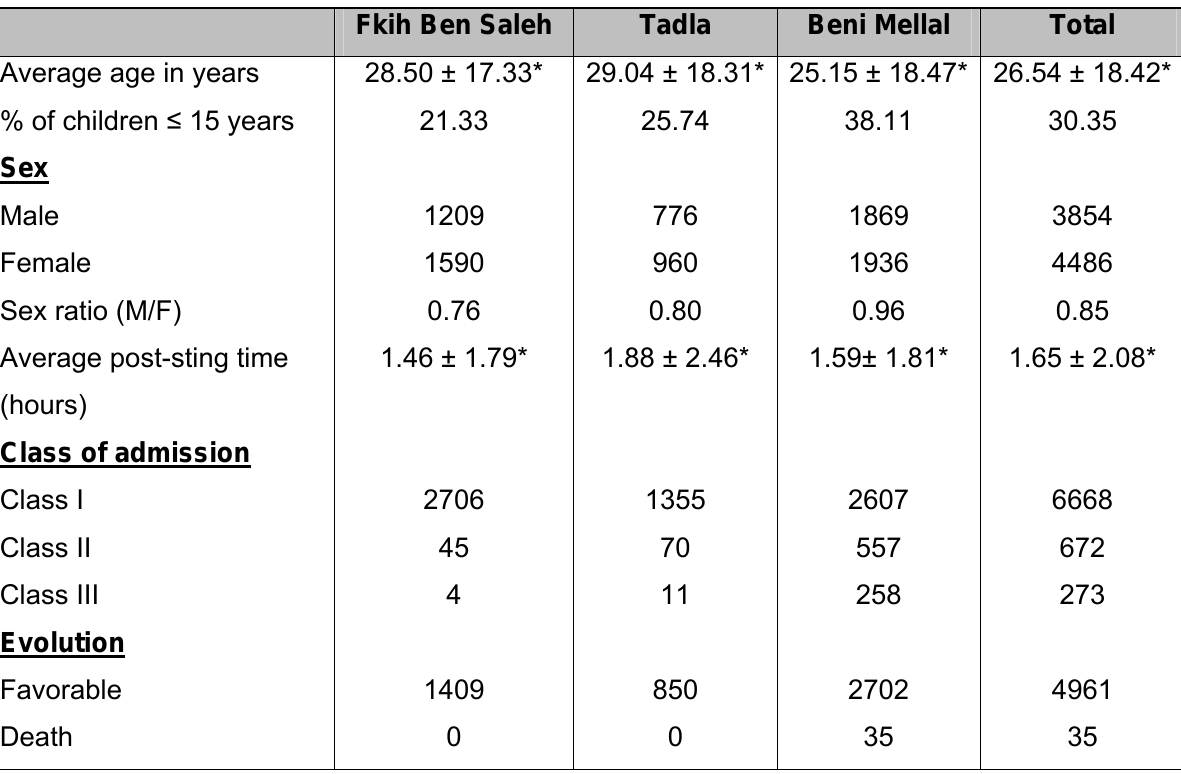
Table 1. Characteristics of stung patients by health